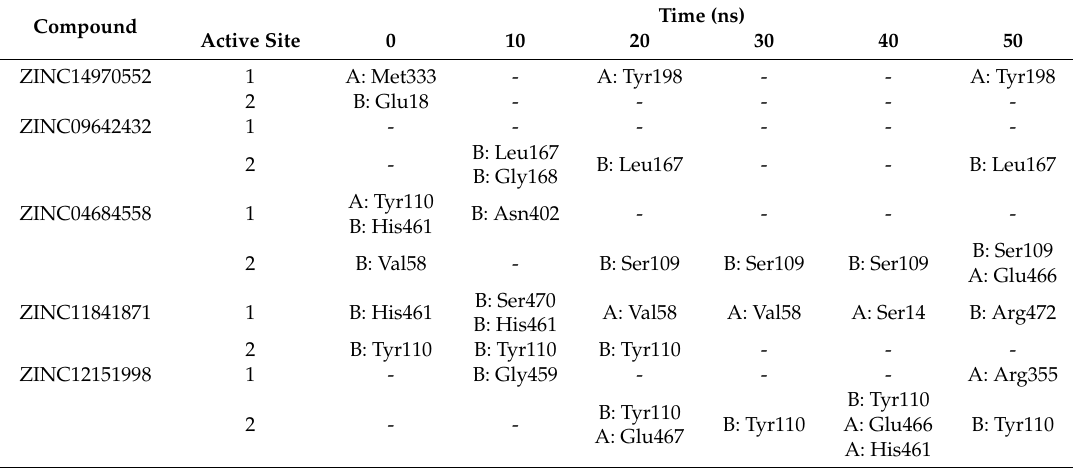
Figure 6. Root-mean-square deviation (RMSD) of LmTR and LmTR–inhibitor complexes. * denotes significant di ff erences with respect to LmTR ( p < 0.05). Statistical analysis was performed by applying ANOVA testing. Table 3. Hydrogen bonding interactions in LmTR–inhibitor complexes at di ff erent times throughout the molecular dynamics